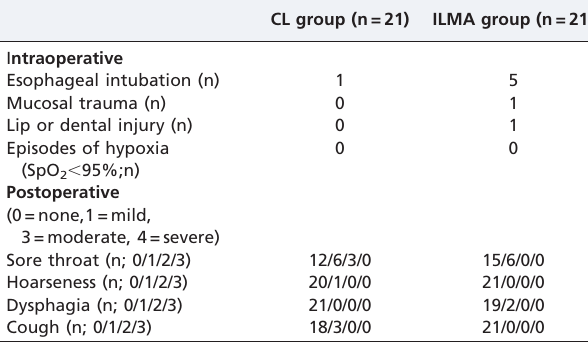
Table 3 - Intraoperative and postoperative airway